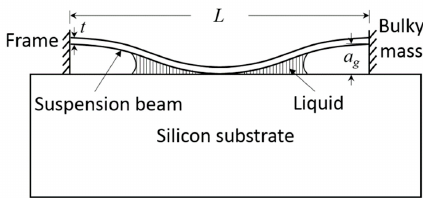
Figure 10. Cross-section view of a clamped–clamped beam adhering to the substrate.